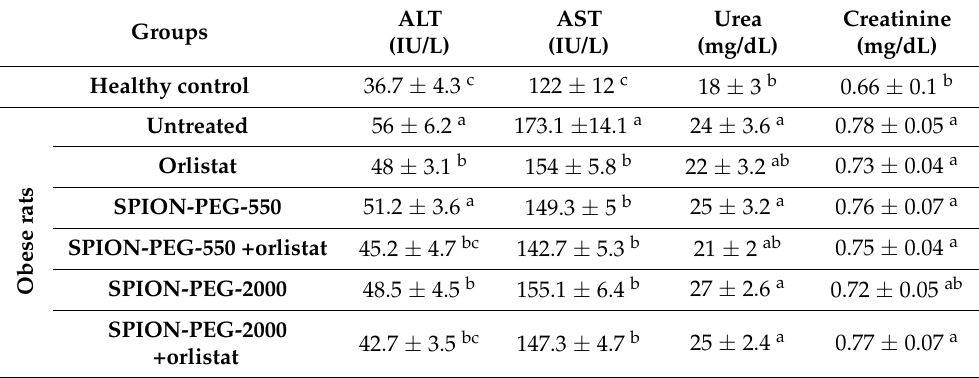
Table 4. Statistical analysis of parameters of liver and kidney function tests in the different stud- ied groups.